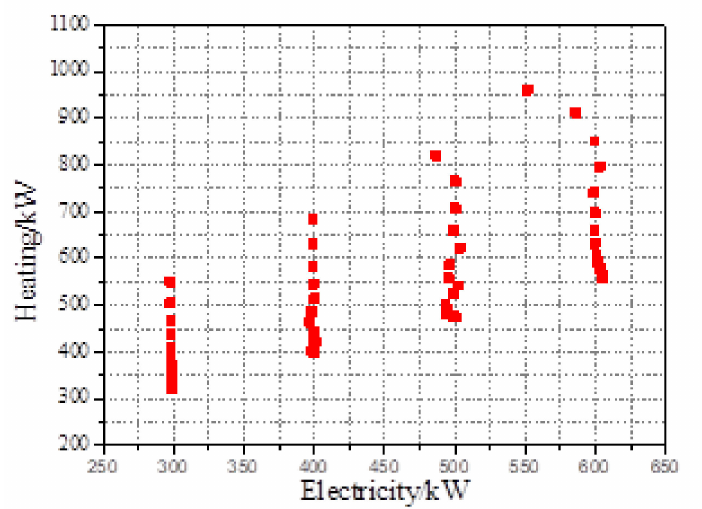
Figure 18. Variable heat/electricity